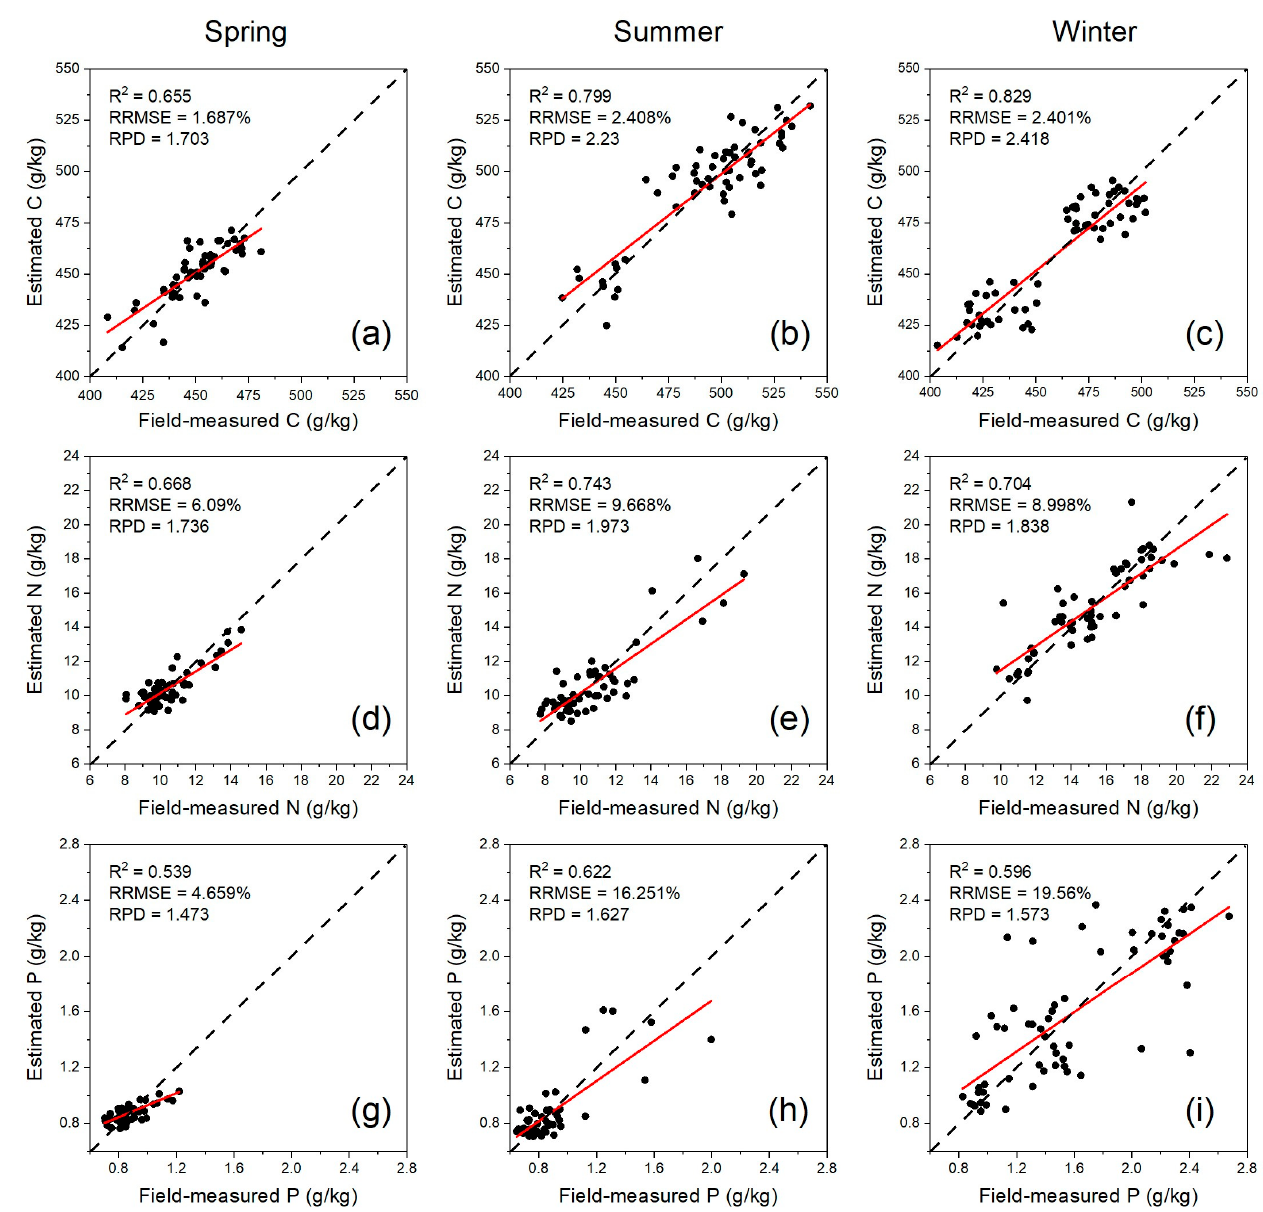
Figure 5. Scatter plots of field-measured versus estimated leaf C ( a – c ), N ( d – f ), and P ( g – i ) using the XGBoost model with the dataset of a single season (the fitted line showed in red). Table 10. The mean absolute error (MAE) of measured versus estimated leaf nutrients in different data groups based on the scatter points of Figure 5.